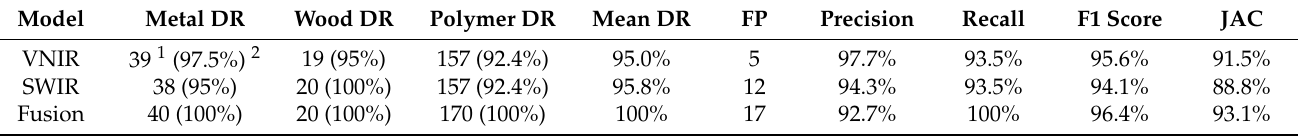
Table 3. Performance of three foreign material blob detection models on the training set. DR refers to detection rate.